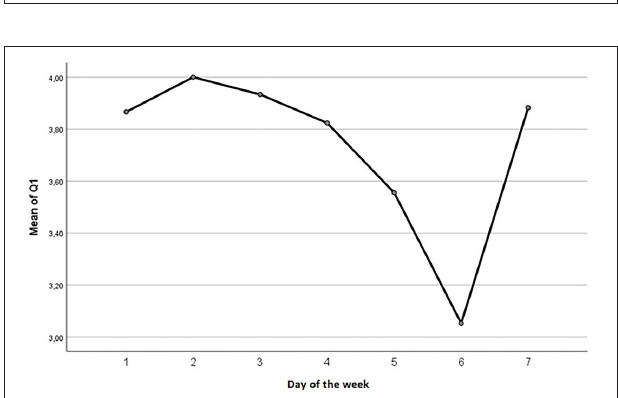
FIGURE 4 | Plotted mean scores for question one, over the course of the week, where 1 represent Monday, 2 Tuesday, etc.